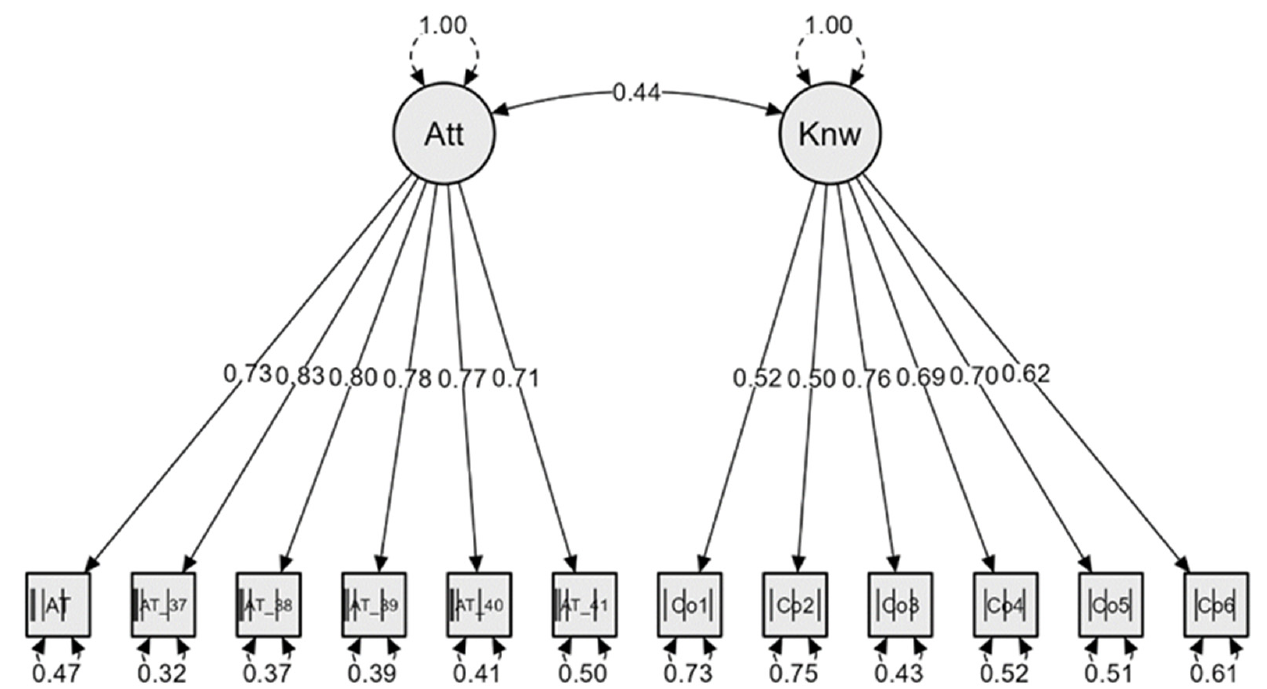
Figure 5. Factor loadings for the area of communication and collaboration. Factor loadings for the content creation area ranged from 0.47 to 0.81, which is consid- ered acceptable and significant (Figure 6).